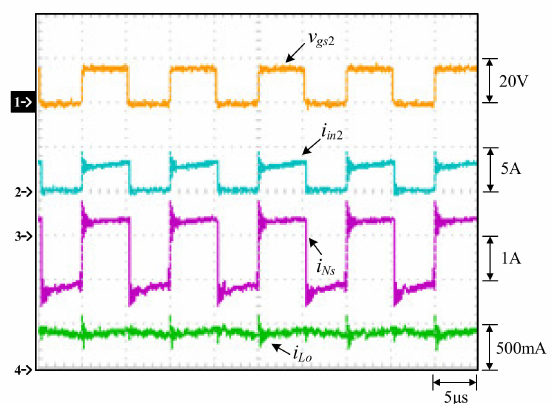
Figure 24. Waveforms measured under the thermoelectric system: (1) v gs 2 ; (2) i in 2 ; (3) i Ns ; (4) i Lo